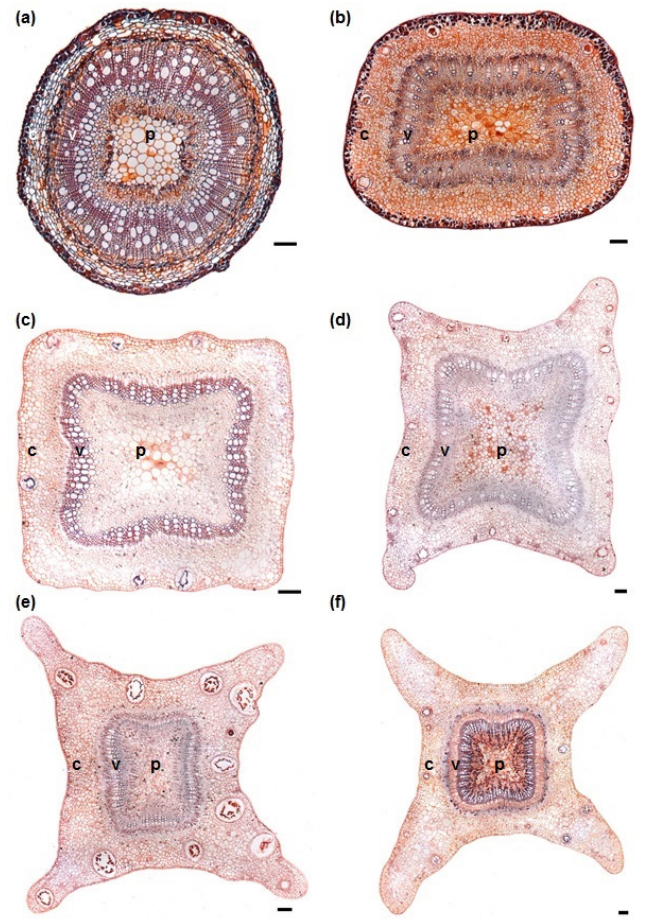
Figure 4. Transverse sections from the stem of cuttings from near the fourth-most apical node (N4) of stock plants of ( a ) Eucalyptus pilularis , ( b ) E. marginata , ( c ) E. grandis , ( d ) E. camaldulensis , ( e ) E. globulus , and ( f ) E. nitens . c = cortex; v = vascular tissue; p = pith. Scale bars = 100